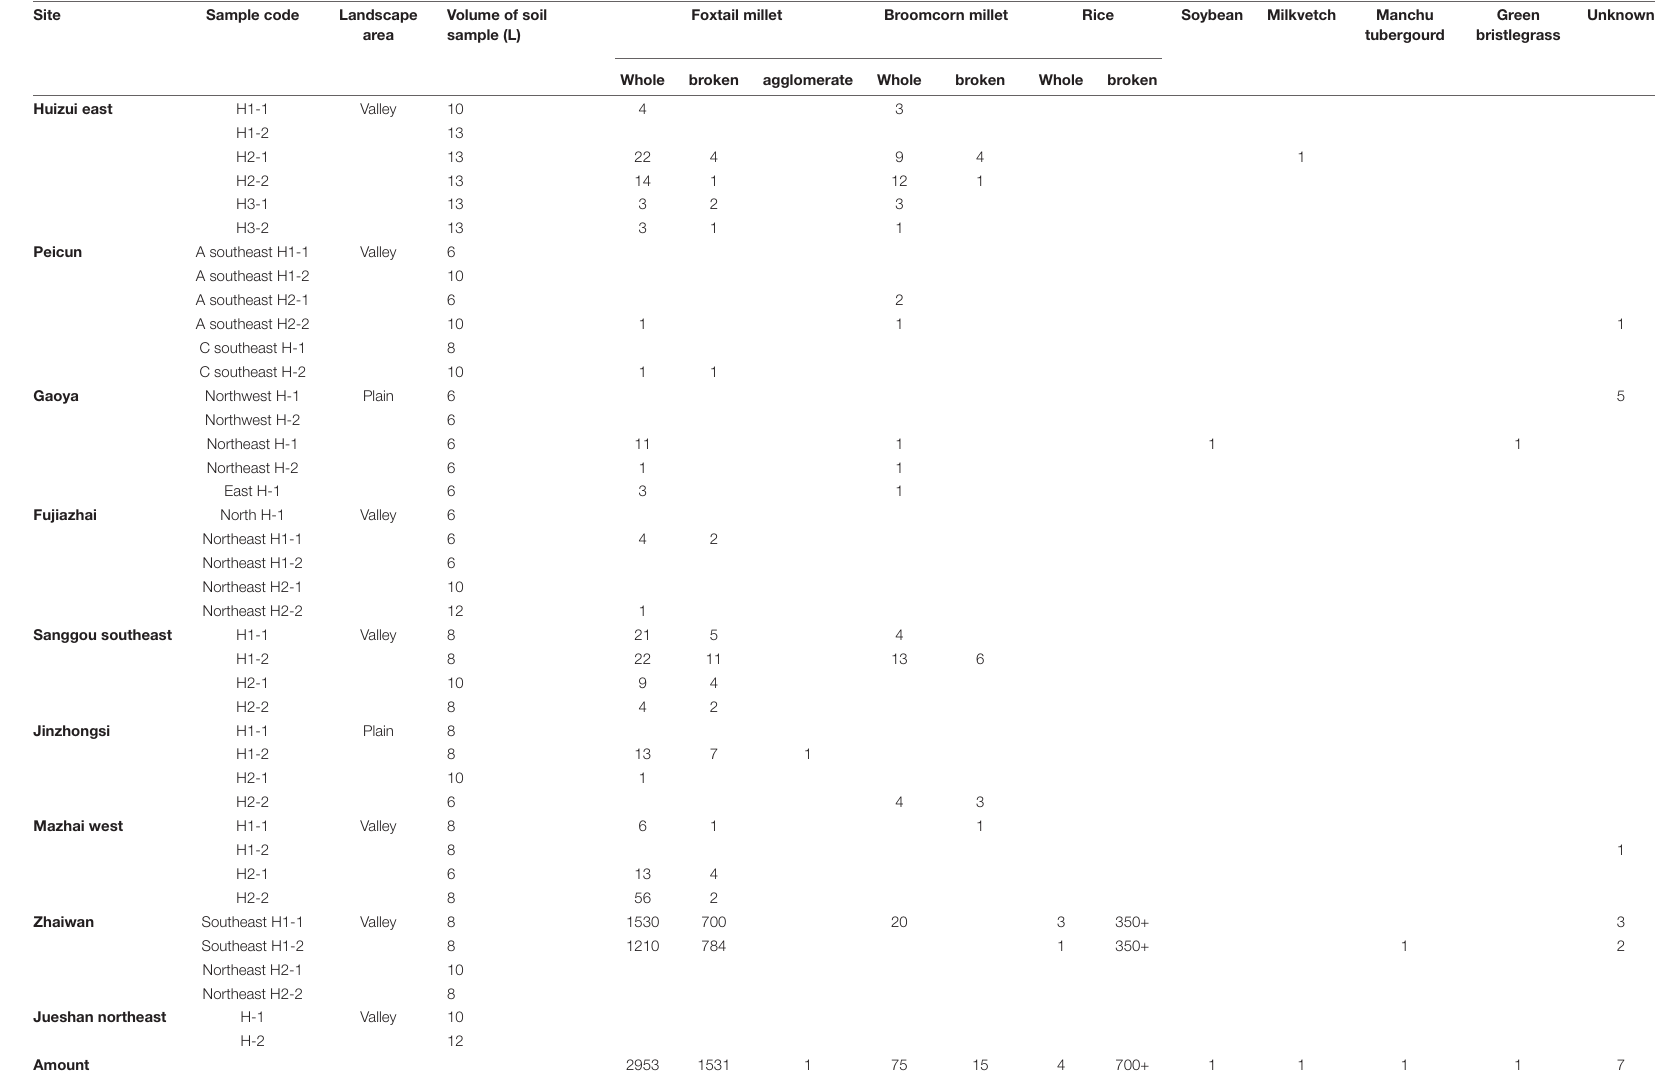
TABLE 2 | Counts of crop seeds remains in the flotation samples from the Late Yangshao period archaeological sites in Luoyang basin (our study).